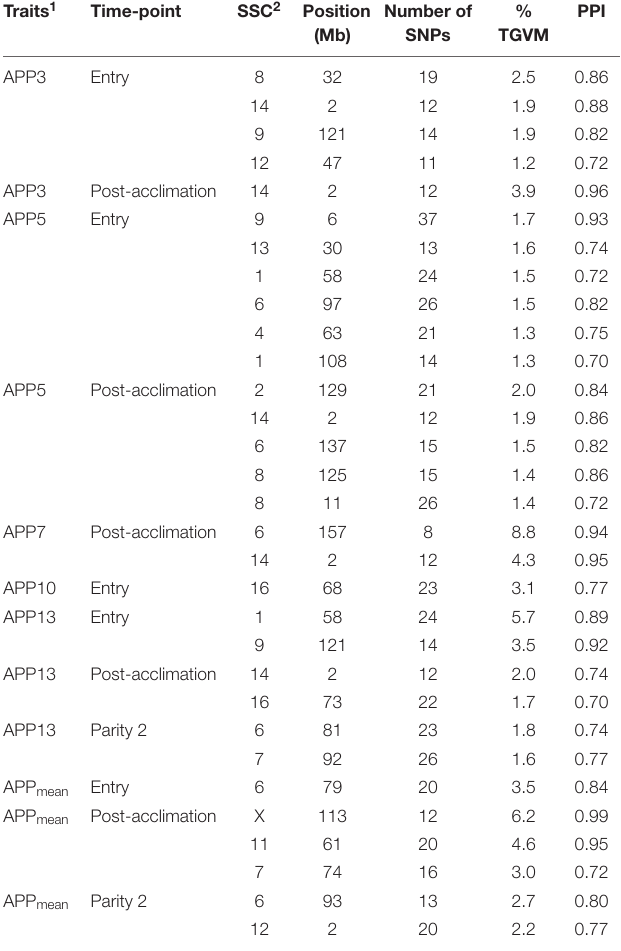
TABLE 5 | Percentage of total genetic variance explained for by markers (% TGVM) within a 1-Mb window for Ab response traits with significant QTLs using a threshold of 1% TGVM and posterior probability of inclusion (PPI) of